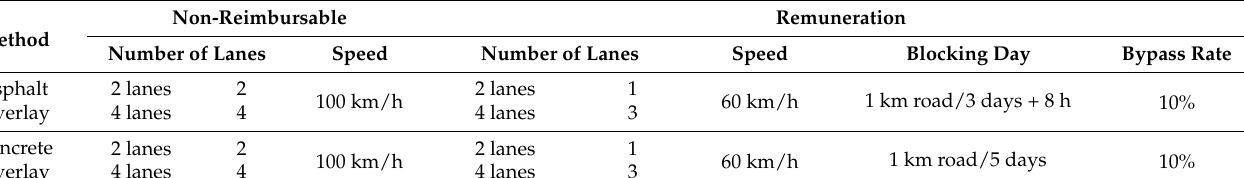
Table 2. Variables applied to user cost (use of shoulder).